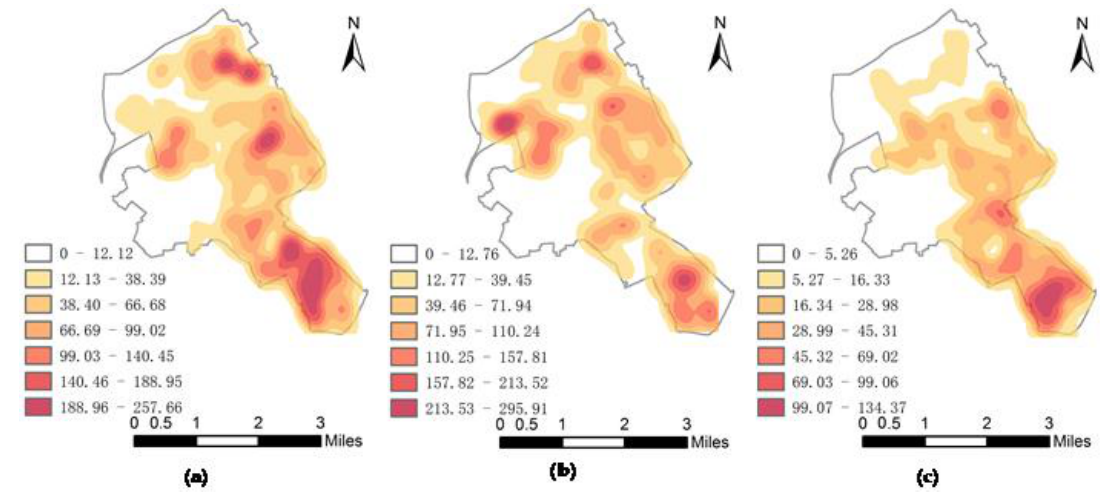
Figure 2. Kernel density estimation of the three types of crime: ( a ) theft of e-bike; ( b ) burglary; and ( c ) robbery.